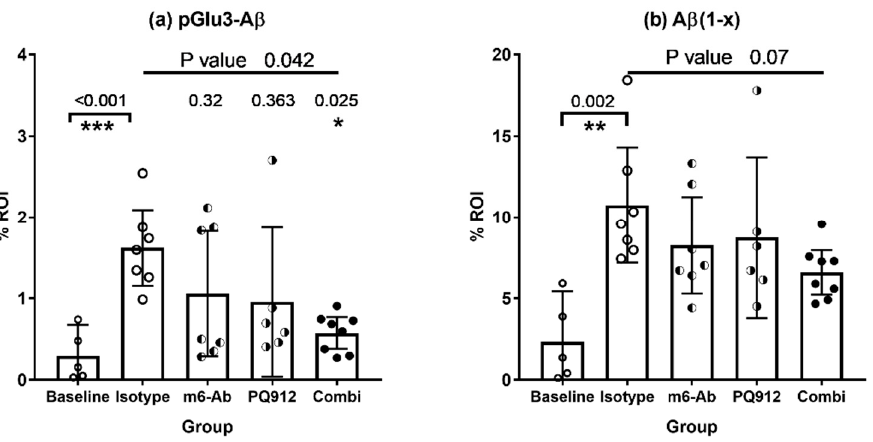
Figure 2. Quantitative immunohistochemistry of brains from hAPPsl × hQC mice after treatment with PQ912 (Varoglutamstat), a monoclonal pGlu-A β antibody (m6-Ab) or in combination for 16 weeks. ( a ) K17 stains pGlu3-A β , ( b ) 82E1 stains the A β N-terminus starting with amino acid 1 [A β (1–x)]. Significant differences between isotype control and baseline ( t -test) indicate a development of A β pathology over the treatment period. In comparison to the isotype control, nominal lower mean A β staining was found in case of all treatments. The combination treatment resulted in significantly reduced staining for pGlu3-A β . Kruskal–Wallis test for group comparison (top line p -value) with Dunn’s test for post-hoc comparison with isotype control ( p -values above bars) (*— p < 0.05, **— p < 0.01, ***— p < 0.001).